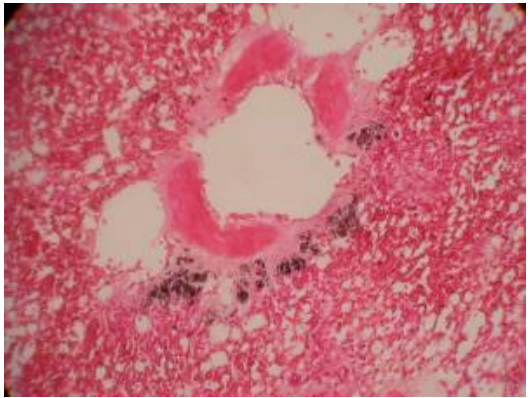
Image 18. Lung of Golden Pheasant showing deposition of carbon particles, congestion and fibrosis, Anthracosis, H&E, 200x.